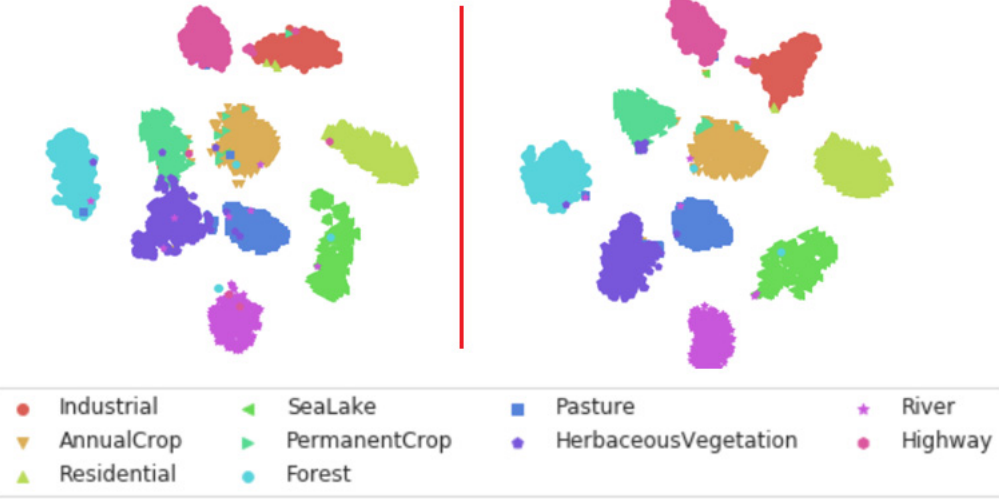
Figure 14. 2-D scatterplots of high-dimensional features generated with t-SNE over the EuroSAT dataset. ( left ) without center-loss function. ( right ) with center-loss function.